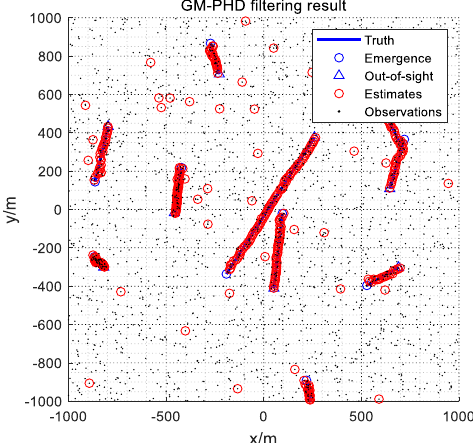
Figure 5. Filter results of GM-PHD filter.